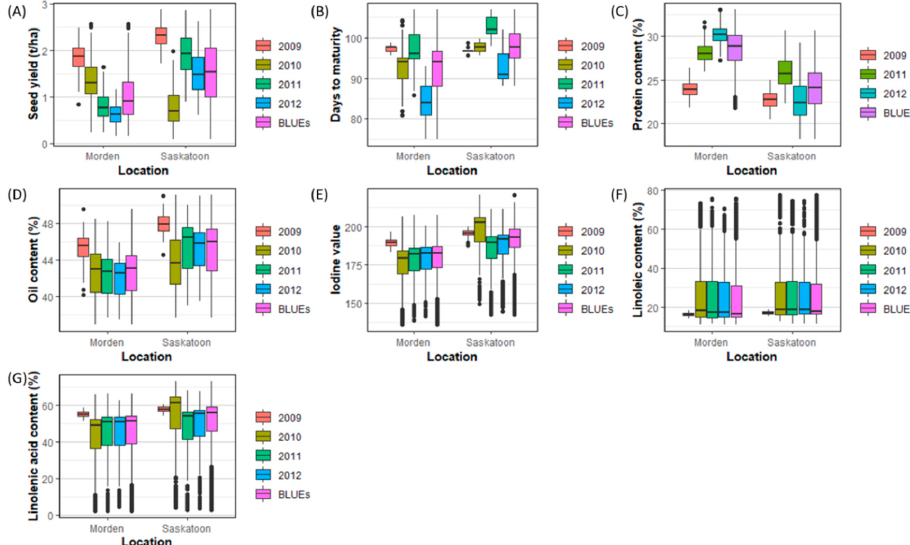
Figure 1. Boxplots of phenotypic data of the seven traits: seed yield (YLD) ( A ), days to maturity (DTM) ( B ), protein content (PRO) ( C ), oil content (OIL) ( D ), iodine value (IOD) ( E ), linoleic acid content (LIO) ( F ), and linolenic acid content (LIN) ( G ). BLUEs, best linear unbiased estimates across four years. Table 1. The haplotype blocks identified from 17,277 single nucleotide polimorphsims (SNPs) in the 260 lines and association with quantitative trait loci (QTL) of traits.